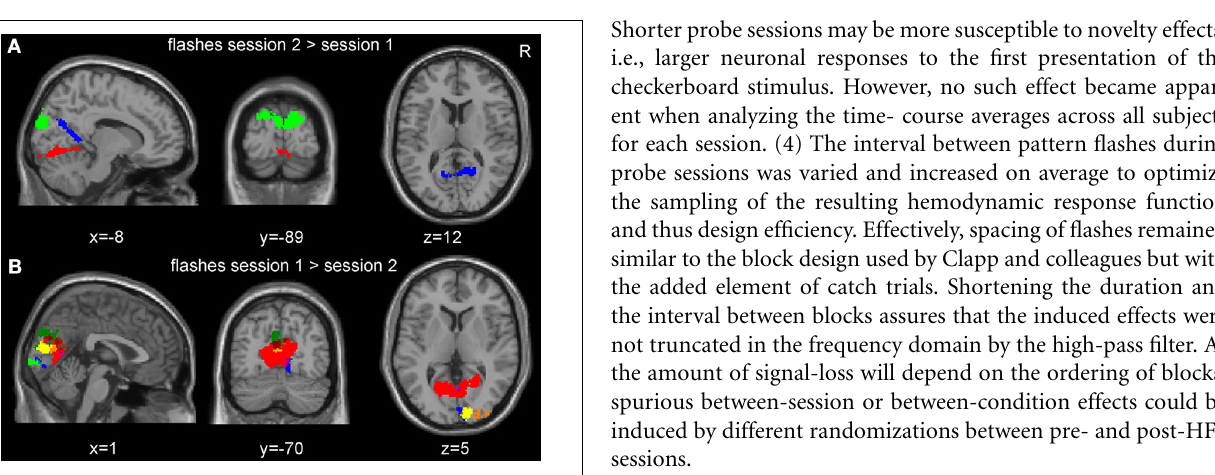
FIGURE 4 | Session effects of the checkerboard flashes at the single subject level. (A) Overlay of all clusters of significantly increased neuronal responses from the single subject analyses in the post- compared to the pre-high frequency stimulation (HFS) session. (B) Overlay of all clusters of significant decreased activation in the post- compared with the pre-HFS session. The clusters from six subjects were partly overlapping. Only clusters within the mask of the visual cortices are displayed here and plotted with a distinct color for each subject (FWE corrected at p < 0 . 05 at the cluster level), for the overlap between the subjects, please refer to Figure S3 (Supplementary